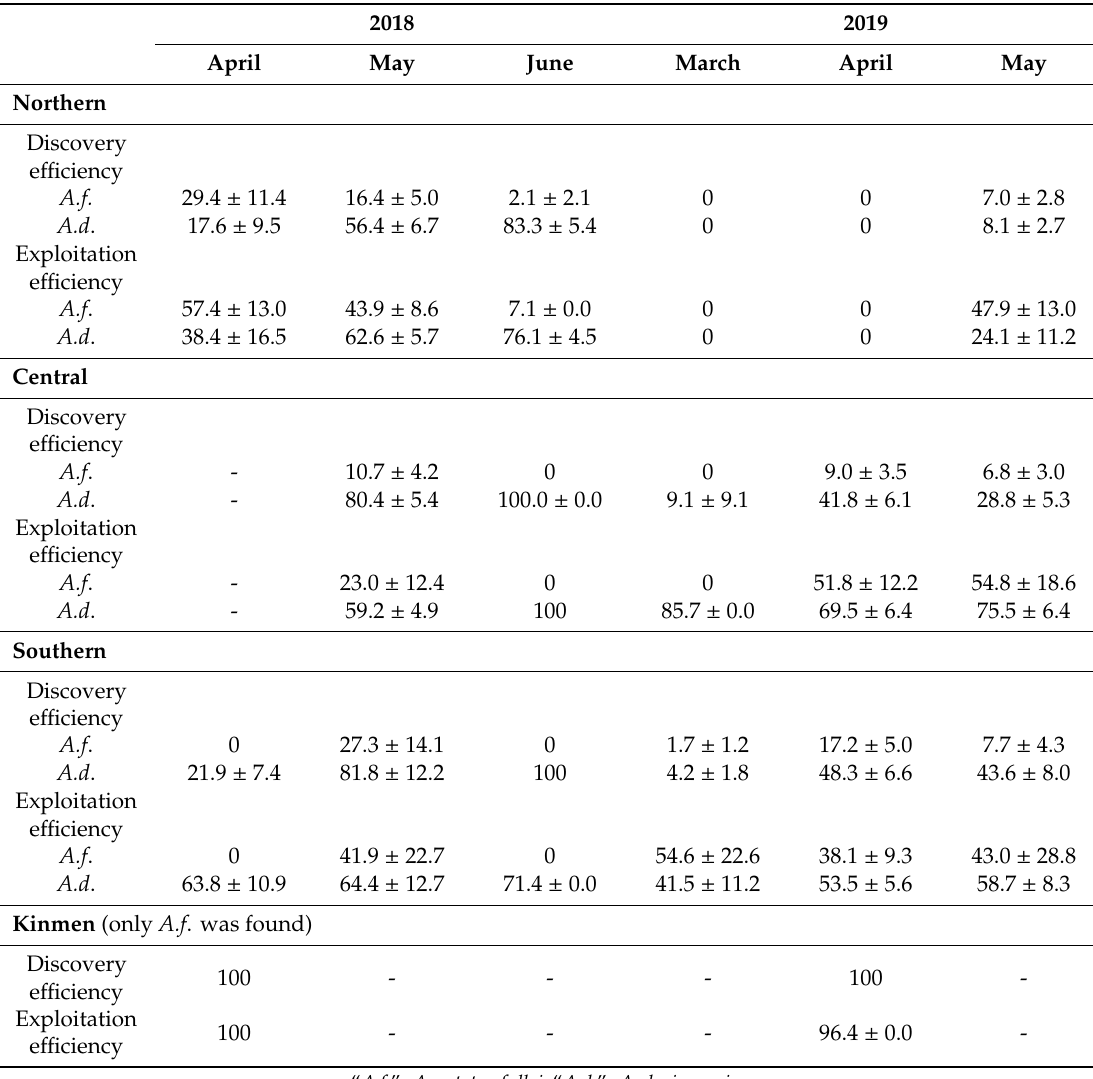
Table 2. Mean ( ± SE) discovery e ffi ciency and exploitation e ffi ciency of each of two major egg parasitoids on LSB egg masses collected in this study during 2-year survey (data on the minor egg parasitoid species were excluded from this